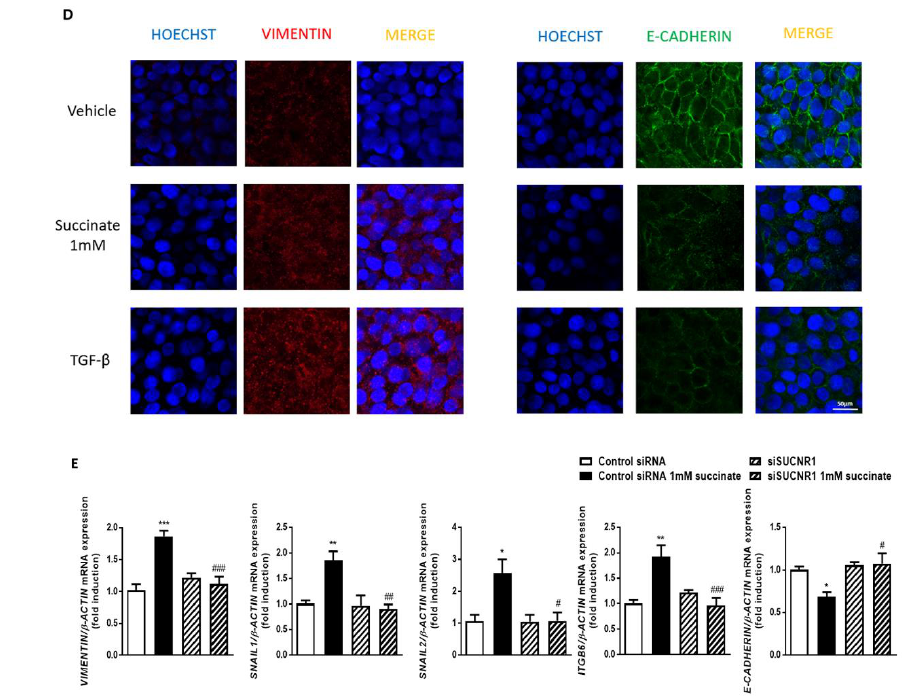
Figure 4. Succinate activates EMT in intestinal epithelial cells through SUCNR1 receptor. HT29 cells were treated with di ff erent concentrations of succinate (0, 0.1, 0.5, 1 and 5 mM) or TGF- β (5 ng / mL) for 48 h. ( A ) Graphs show the mRNA and protein expression of SUCNR1 receptor in HT29 cells ( n = 5). The images correspond to a Western blot representative of a total of 5 independent experiments. ( B ) Graphs show the mRNA expression of the EMT markers, VIMENTIN, SNAIL1, SNAIL2 and ITGB6 in HT29 cells ( n = 5). Bars in graphs represent mean ± SEM, and significant di ff erences vs. non-treated HT29 cells are shown by * p < 0.05, ** p < 0.01 or *** p < 0.001. ( C ) Graphs show the mRNA and protein expression of E-CADHERIN in HT29 cells ( n = 5). The image corresponds to a Western blot representative of a total of 5 independent experiments. ( D ) Immunofluorescence of VIMENTIN and E-CADHERIN in HT29 cells treated with 1 mM of succinate or TGF- β for 7 days. Representative pictures of a total of 3 independent experiments. ( E ) Graphs show the expression of VIMENTIN, SNAIL1, SNAIL2, ITGB6 and E-CADHERIN in HT29 cells transiently transfected with a specific siSUCNR1 or with a control siRNA and treated with succinate 1mM for 48 h post-transfection. ( n = 5). Bars in graphs represent mean ± SEM, and significant di ff erences vs. control siRNA non-treated HT29 cells are shown by * p < 0.05, ** p < 0.01 and *** p < 0.001 and vs. siSUCNR1 non-treated HT29 cells are shown by # p < 0.05, ## p < 0.01 and ### p <